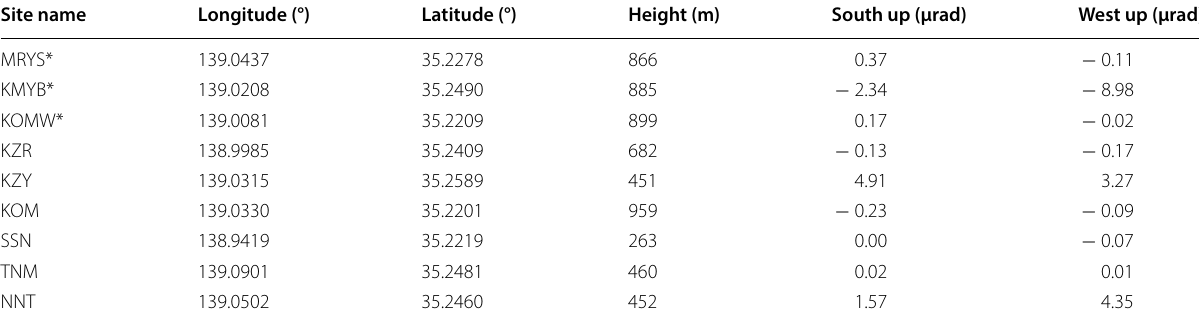
Northward and eastward tilt changes are represented by positive values. The reported static tilt changes are 1 min averages of the tilt data recorded from 7:29 to 7:30 a.m. from 7:35 to 7:36 a.m